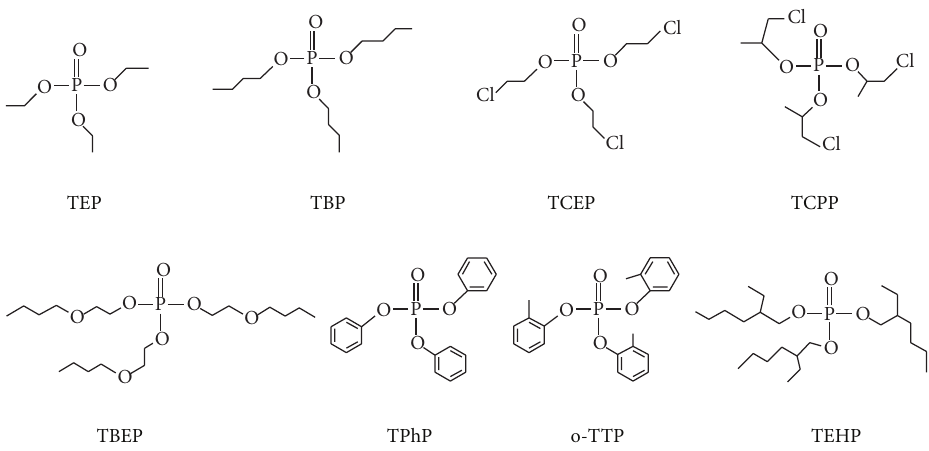
Figure 1: Structures of eight organophosphate esters